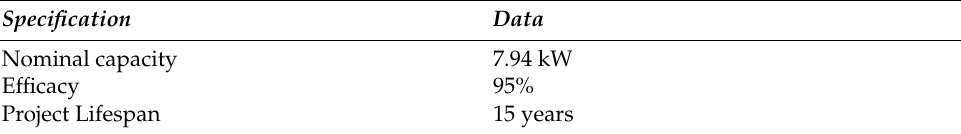
Table 4. Technical specification of the system converter.